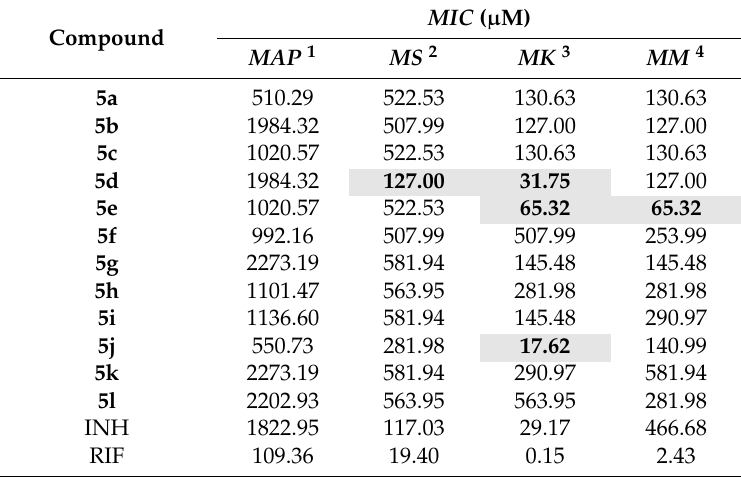
Table 4. Antimycobacterial screening in vitro ( MIC ) of the compounds 5a – l compared to the isoniazid (INH) and rifampicin (RIF)